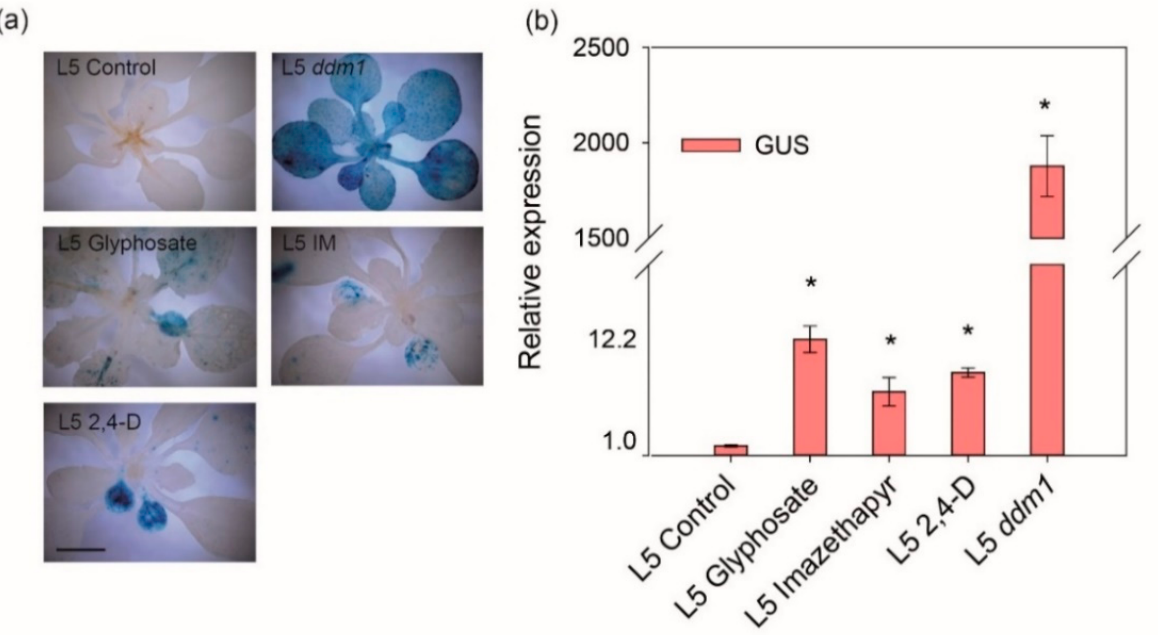
Figure 1. Herbicide stress effect on epigenetically regulated transcription. ( a ) Representative β -Glucuronidase ( GUS )-stained shoots of the plants of line L5, 48 h after treatment with glyphosate, imazethapyr (IM) and 2,4-D, non-treated plant (L5 control) and L5 ddm1 plant serving as a positive control. Plants line L5 are carrying a single insert of a multicopy 35S Cauliflower Mosaic Virus Promoter driven GUS ( Pro35S::GUS ) locus in L5/6b5 line, gene suppressed by transcriptional gene silencing (TGS), all mutants are in the Col-0 background. Scale bar = 1 cm. ( b ) Relative transcript abundance of GUS in L5 measured by RT-qPCR 48 h after the treatment. Error bars indicate the standard deviation of the three biological replicates. Statistically significant differences relative to L5 control are indicated by asterisks ( t -test, p ≤ 0.05); * compared to L5 Control.